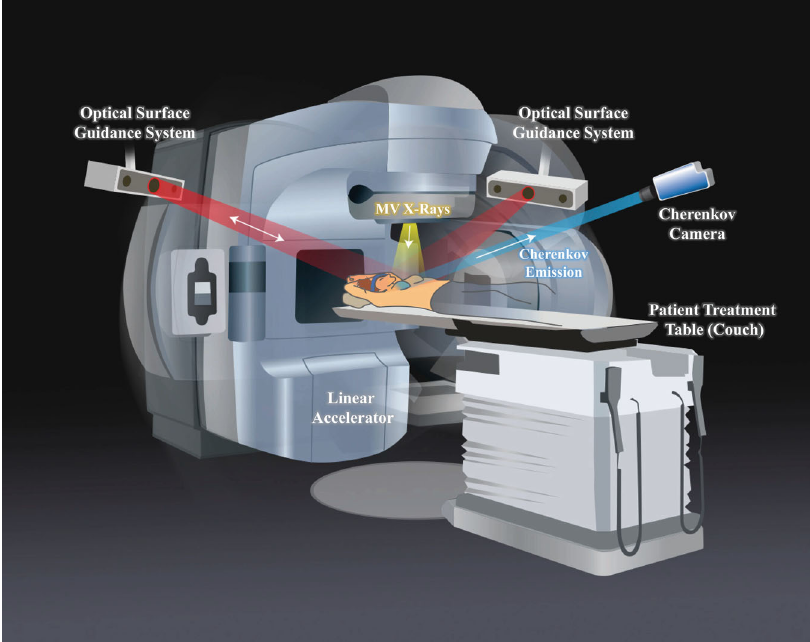
Fig. 1 Study setup and patient positioning. The Cherenkov camera and optical surface guidance projectors and cameras were fi xed to the ceiling. The linear accelerator (linac) gantry rotates to each beam position and remains stationary for delivery of each fi eld. When the linac beam of X-rays (yellow) is incident upon the tissue, Cherenkov light is emitted isotropically from within. Some of this light is detected by the Cherenkov camera (blue). The camera intensi fi er is triggered on during only the linac pulses, thereby suppressing ambient light interference. The optical surface guidance system cameras are used to set up the patient and ensure correct alignment by casting a red, diffuse light pattern onto the patient, and tracking respective